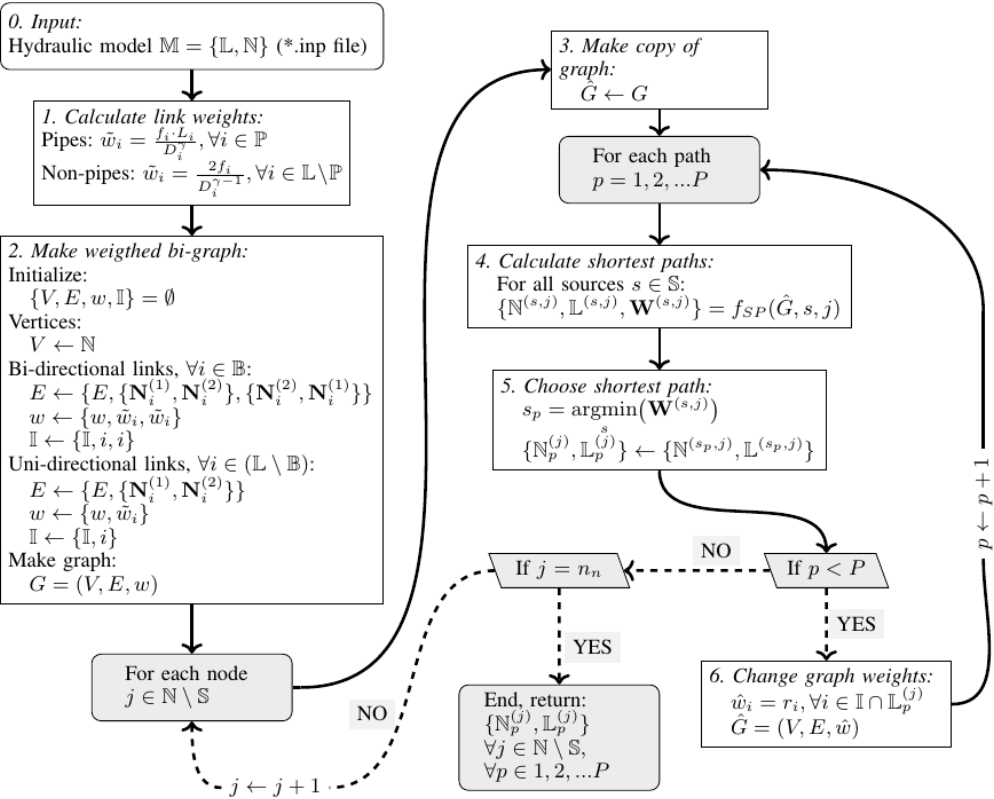
Figure 2. Flow chart with suggested algorithm for identifying principal